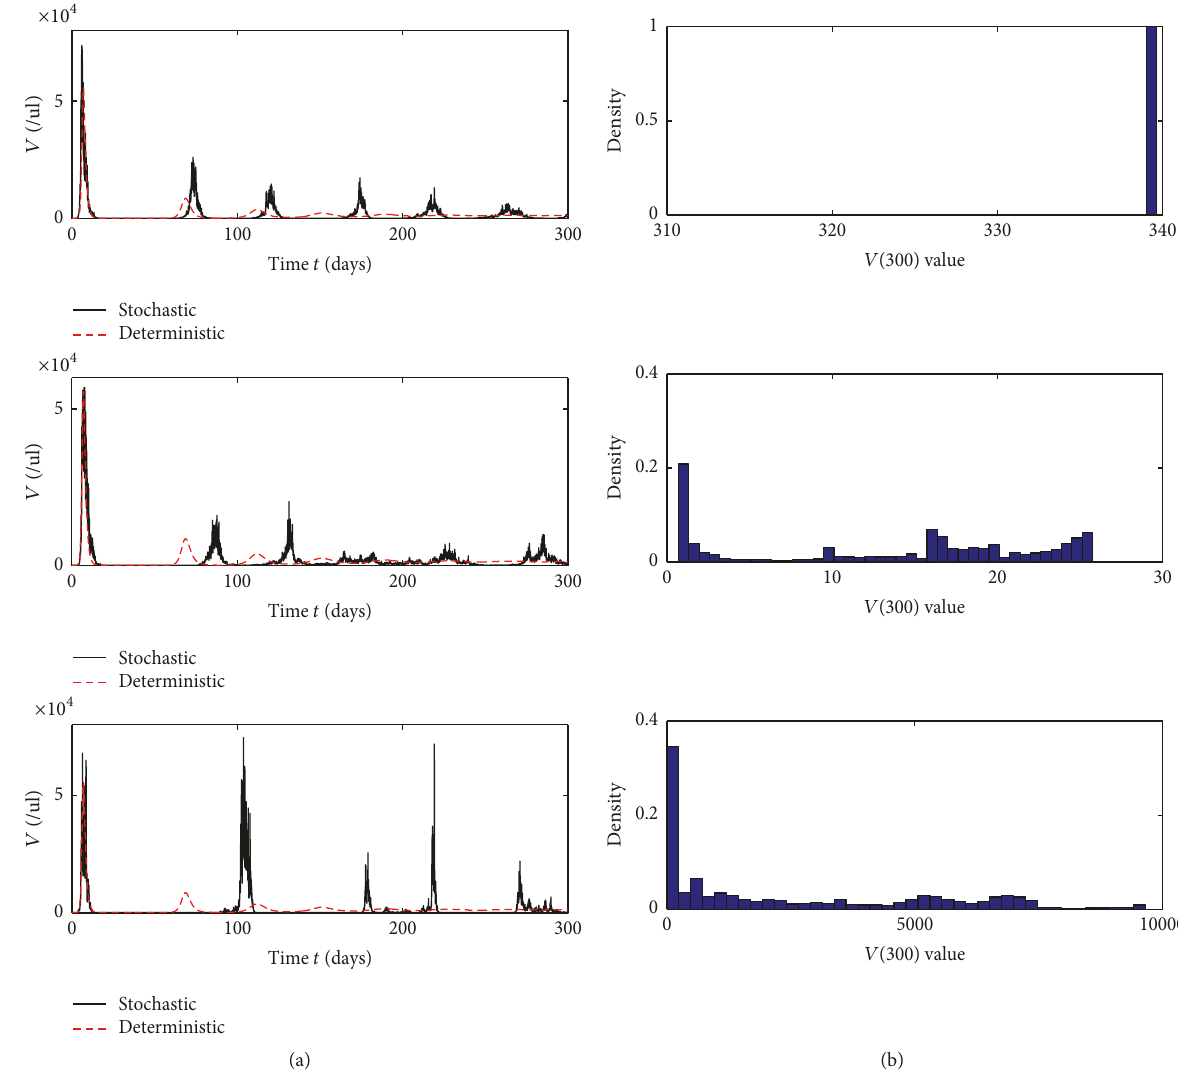
Figure 2: (a) Simulations of virus for the stochastic model (3) and its corresponding deterministic model (1) with three different sets of white noise. (b) Probability density of the values of the path 𝑉(𝑡) at 𝑡 = 300 for system (3) based on 10000 simulation runs. For parameters see Table 1 with (𝜎 1 , 𝜎 2 , 𝜎 3 ) equal to (0.008, 0.3, 1) , (0.01, 0.4, 1.2) , and (0.02, 0.8, 1.5) ,